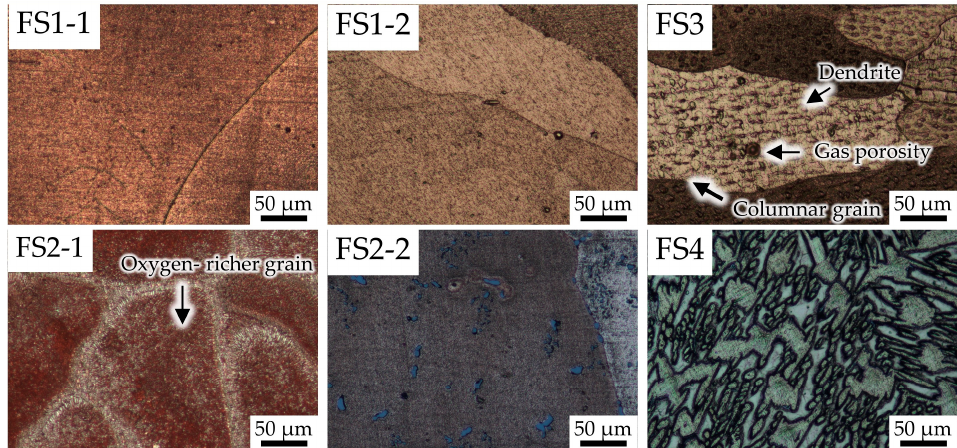
Figure 7. Etched microstructure of the molten marks under magnification 200×.